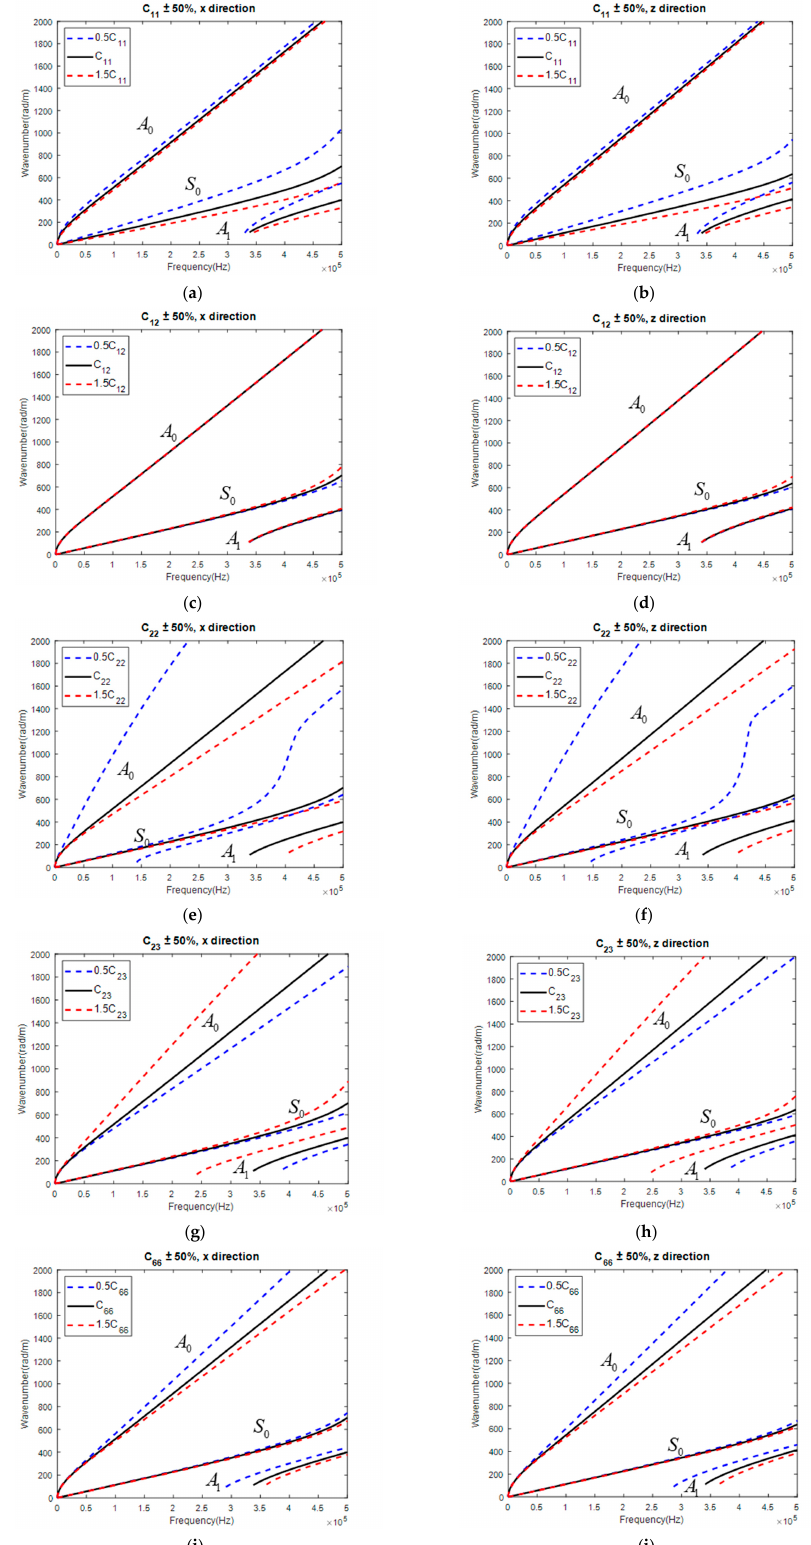
Figure 8. Influence of parameter on GW dispersion curve in QI: C 11 on GW along ( a ) x and ( b ) z direction; C 12 on GW along ( c ) x and ( d ) z direction; C 22 on GW along ( e ) x and ( f ) z direction; C 23 on GW along ( g ) x and ( h ) z direction; C 66 on GW along ( i ) x and ( j ) z With the proposed GW-based GA, the reconstructed values of the stiffness matrix with different image resolutions (251 × 251, 501 × 501, 1001 × 1001, and 2001 × 2001) and the maximum relative deviation in percentage defined below are listed in Table 5,